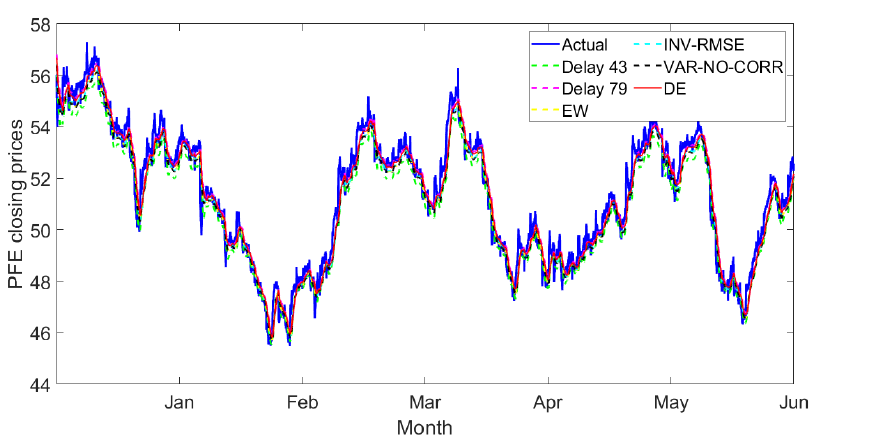
Figure 12. The forecasting curve for actual data versus the individual and combination methods of PFE stock obtained from the MLP model between January and June